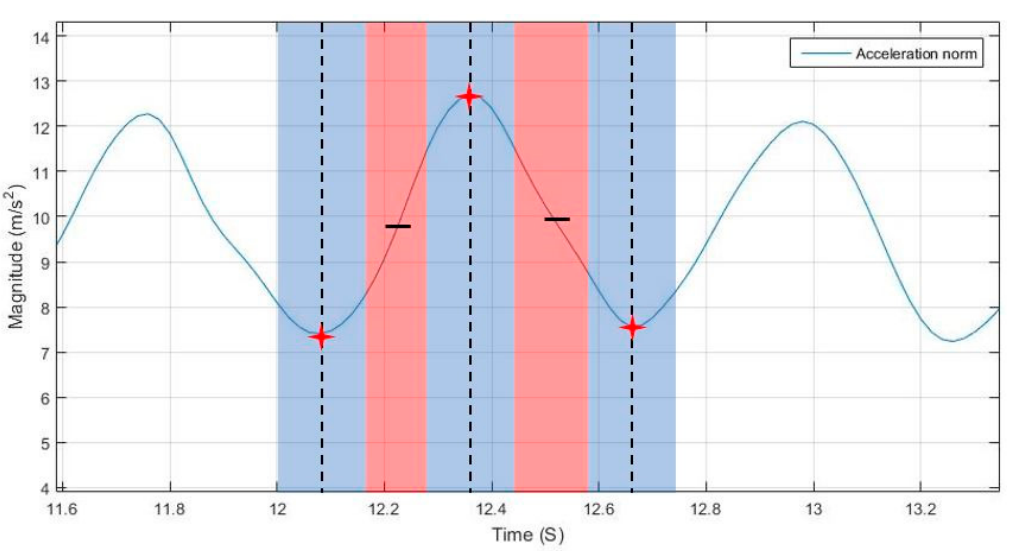
Figure 9. Update and rejection zones for peak/valley detection.